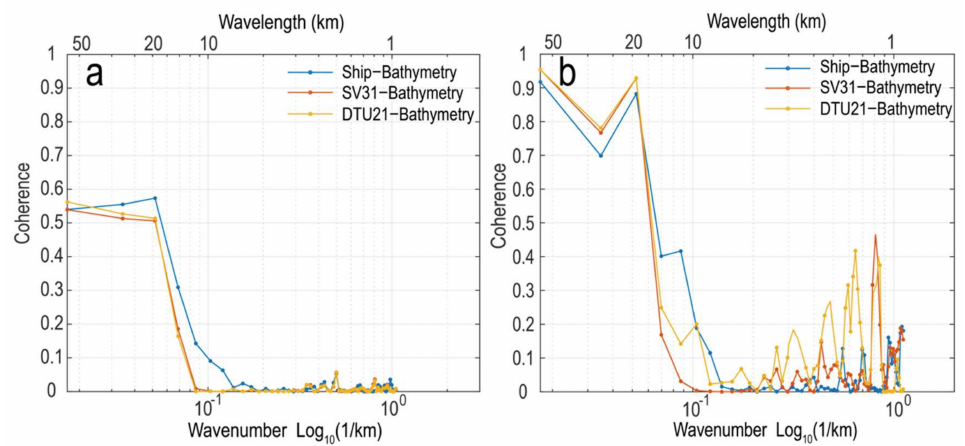
Figure 8. ( a ) Coherence of the bathymetry with the gravity fields from the shipborne and satellite altimetric gravity data in Arctic-18 region. ( b ) Coherence of the bathymetry with the gravity fields from the shipborne and satellite altimetric gravity data in Arctic-20